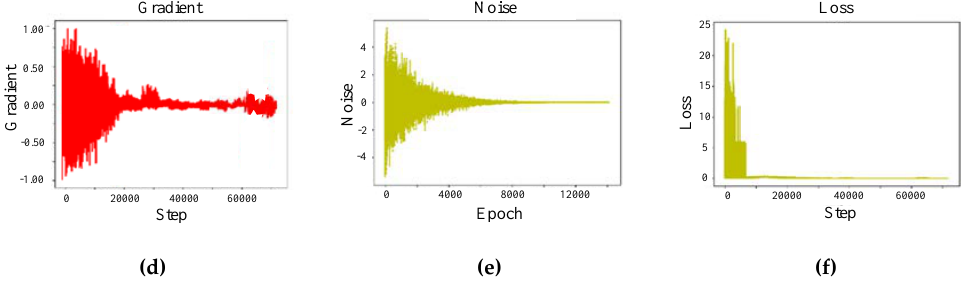
Figure 7. Training results of the deep reinforcement learning model.